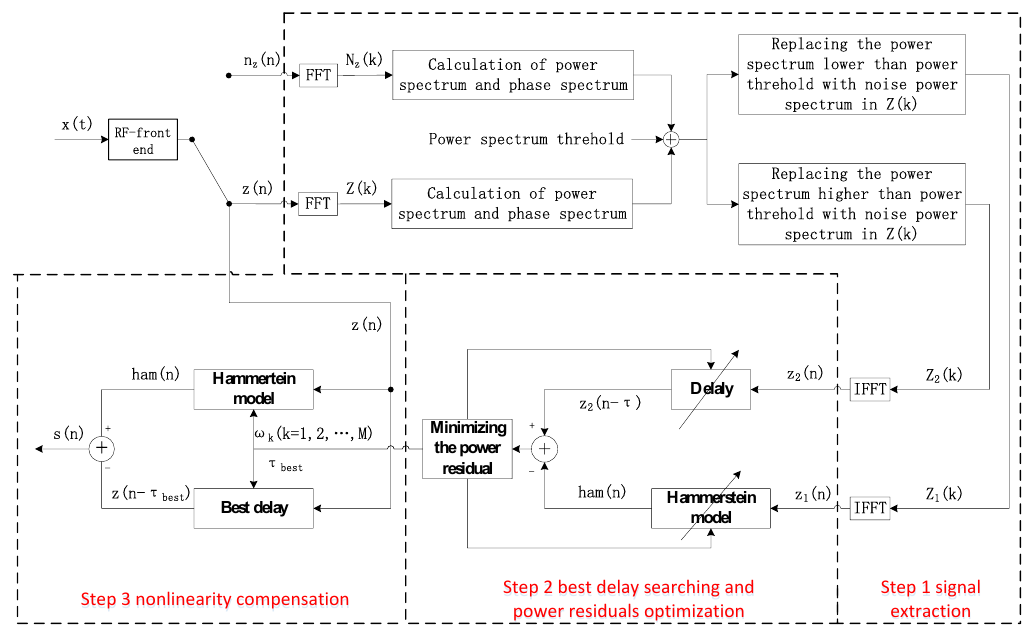
Figure 4. Mitigation architecture.